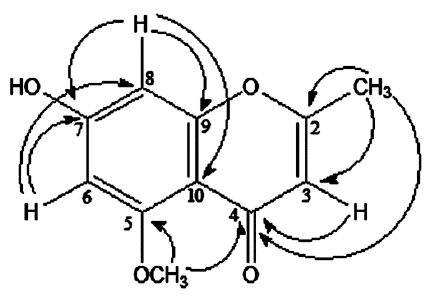
Figure 1. Structure of isoeugenin ( 1 ) isolated from I. cylindrica var. major and heteronuclear multiple-bond correlation spectroscopy (HMBC) correlation.